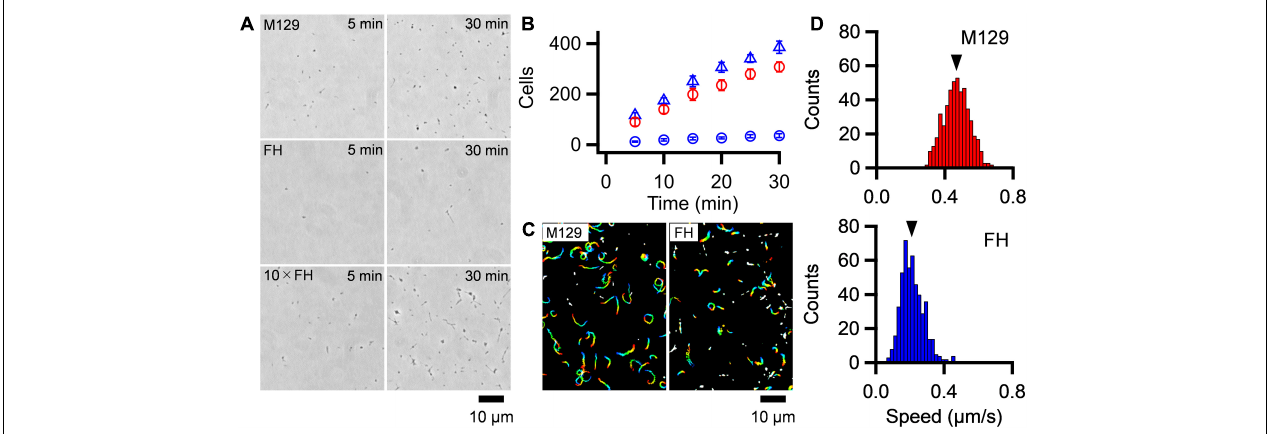
FIGURE 5 | Binding activity and gliding motility. (A) Phase-contrast micrographs of cells on SO-coated glass surfaces. M129, FH, and 10 × concentrated FH are shown after 5 and 30 min of incubations. (B) Averaged bound cell numbers in 100 µ m × 100 µ m plotted with standard deviations ( n = 10 in each). M129 (Red open circle), FH (Blue open circle), and 10 × concentrated FH (Blue open triangle) are presented. (C) Cell trajectories for 20 s, changing color with time from red to blue. (D) Distributions of gliding speeds averaged for 20 s at 1-s intervals ( n = 500 in each). The mean values are marked by black